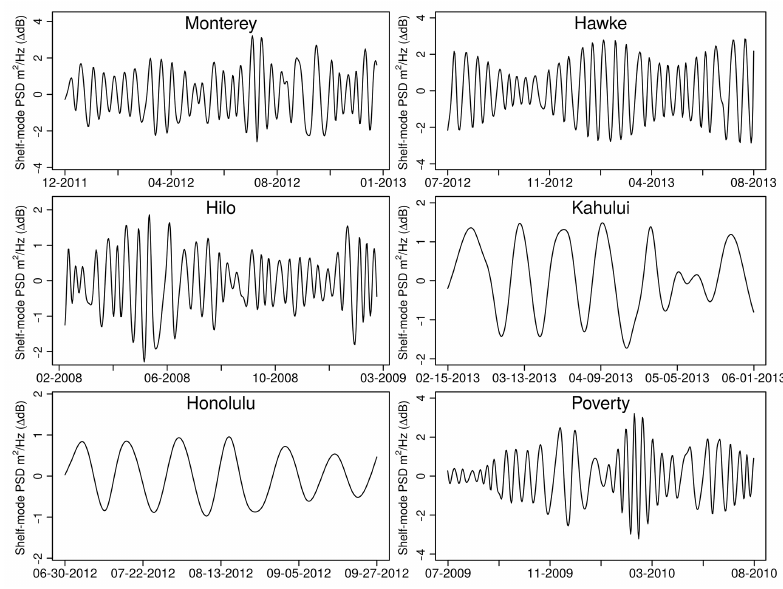
Figure 6. Intrinsic mode functions (IMF) of shelf-mode amplitude variance (metamodes) with mean Hilbert instantaneous frequencies corresponding to fortnightly periods (highlighted in Table 5). Amplitudes are with respect to the mean values shown in Fig. 5. Records at Honolulu and Kahului are limited to 3 months, while the other stations show excerpts of approximately 13 months.